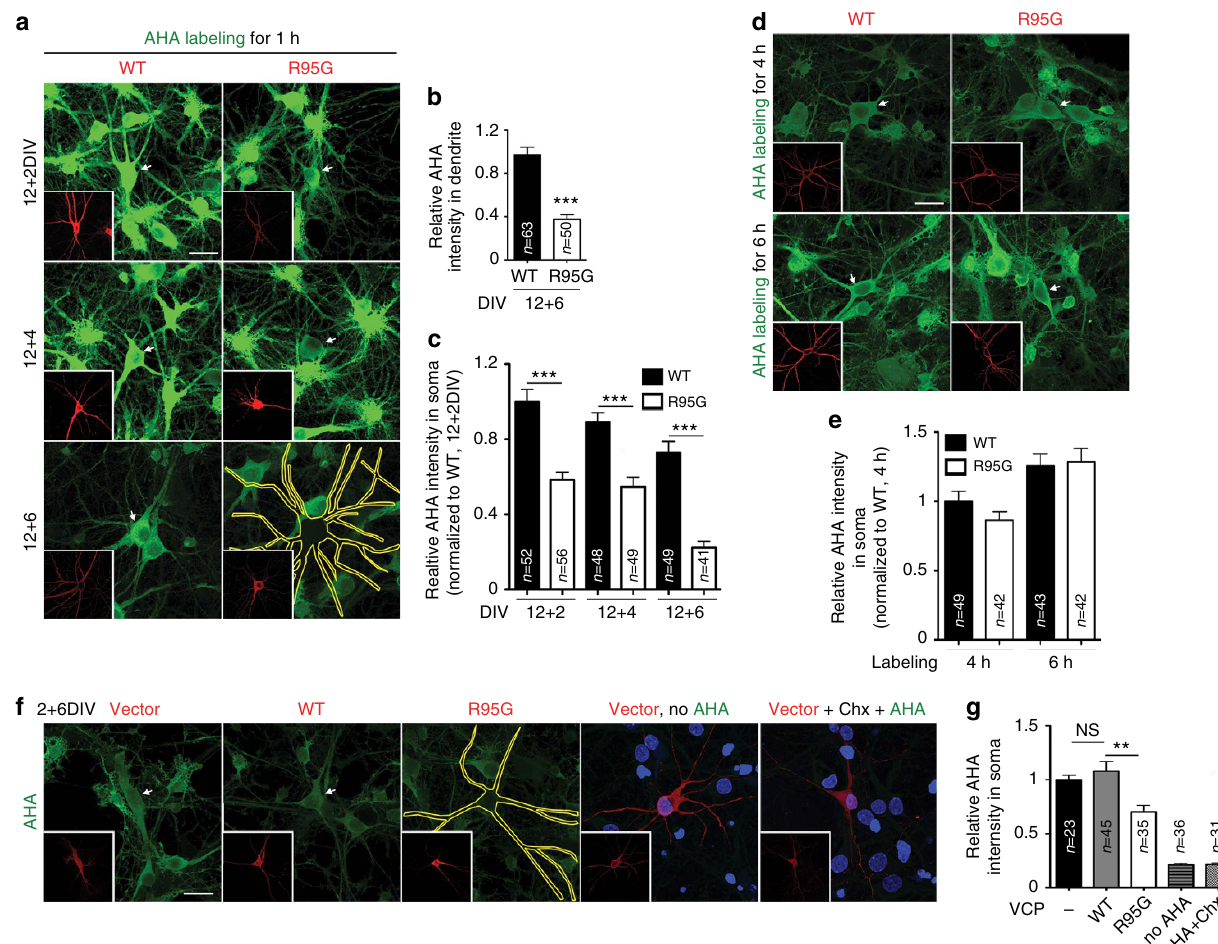
Figure 5 | Expression of the VCP R95G mutant reduces protein synthesis efficiency. Cultured neurons were transfected with WT VCP or the R95G mutant at ( a – e ) 12 DIV and ( f , g ) 2 DIV, and protein synthesis was analyzed using AHA labeling at 2, 4 or 6 days later, as indicated. AHA labeling was detected with alkyne-modified Alexa Fluor-488. ( a , d , f ) Representative images of the AHA labeling. The insets indicate the transfected cells, which are either outlined or indicated by arrows in the original images. ( b ) Relative AHA intensities in the dendrites. ( c , e , g ) The relative AHA signals in the somata. In ( a – c , f , g ), AHA was labeled for 1h; in ( d , e ), AHA was added to the culture for 4 or 6h, as indicated. In ( f ), AHA omission or cycloheximide addition (Chx; 10 m M) was used to confirm the specificity of the AHA labeling. Scale bar: 25 m m. The sample sizes ( n ) of the analyzed neurons are indicated. The data from three independent experiments are presented as the mean þ s.e.m. (error bars). NS, non-significant; ** P o 0.01; *** P o 0.001. Unpaired t -test ( b , c , e ); one-way ANOVA ( g